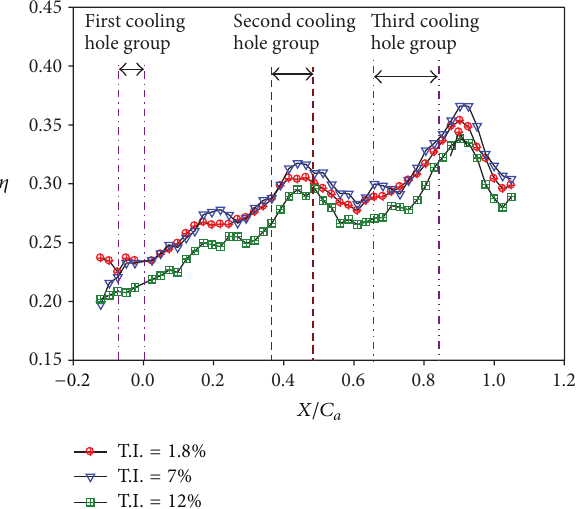
Figure 23: Effect of turbulence intensity on averaged effectiveness for backward-facing stepped endwall (Re = 124000 , 𝑀 = 2 , and 𝑆/𝐶 = −4